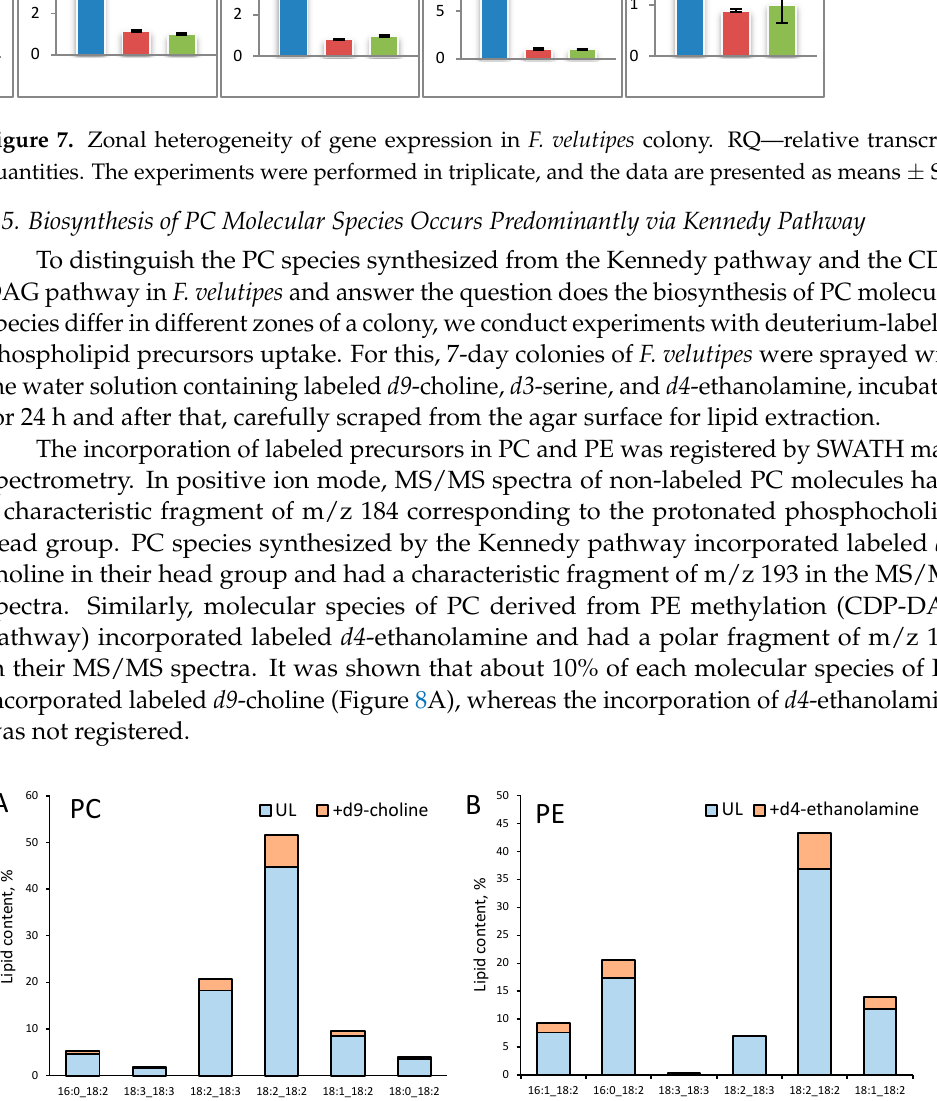
Figure 7. Zonal heterogeneity of gene expression in F. velutipes colony. RQ—relative transcript quantities. The experiments were performed in triplicate, and the data are presented as means ± SD.